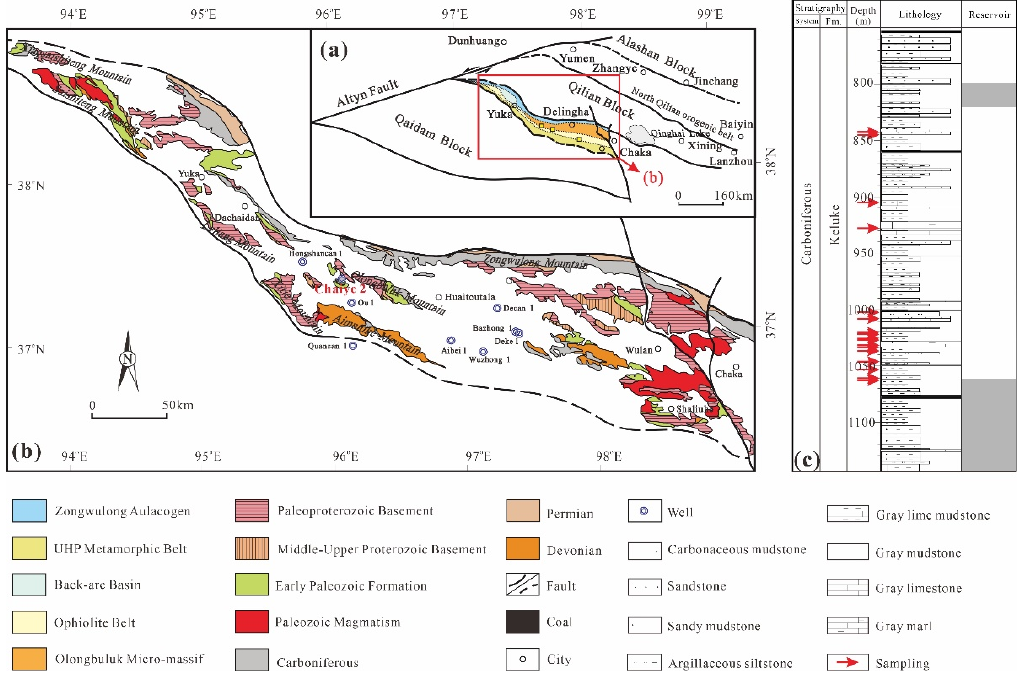
Figure 1. Geological settings: ( a ) geological map of Qaidam Basin; ( b ) geological map of Delingha Depression; ( c ) general stratigraphy of well Chaiye 2 (modified after Wang et al. [10]).